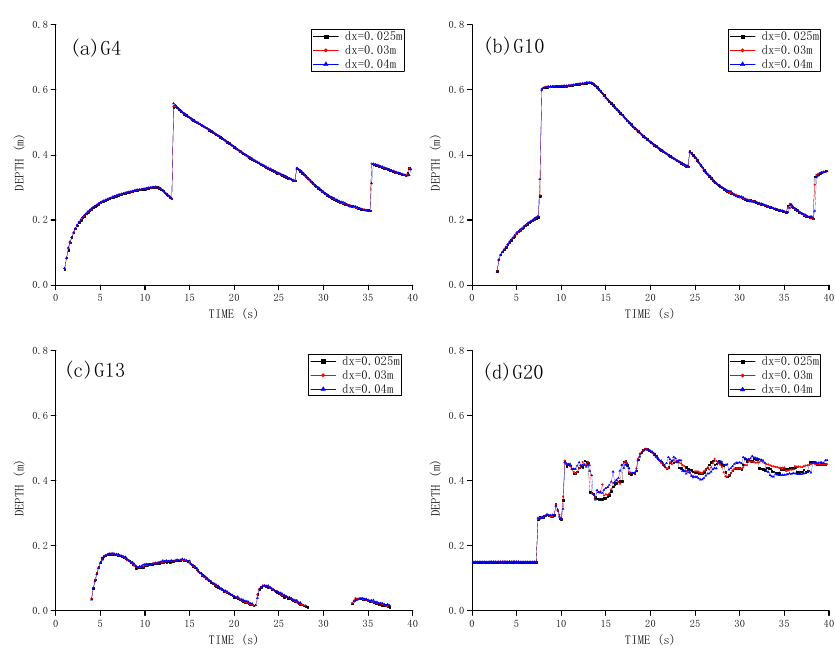
Figure 7. Time histories of dam break flow surface profile at gauging points for three SWE-SPHysics modeling results on [19] at: ( a ) G4; ( b ) G10; ( c ) G13; and ( d ) G20.